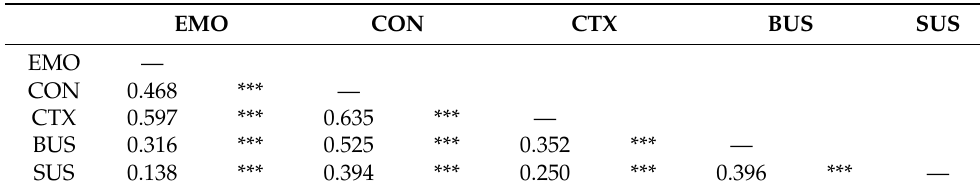
Table 2. Correlation matrix between studied variables.